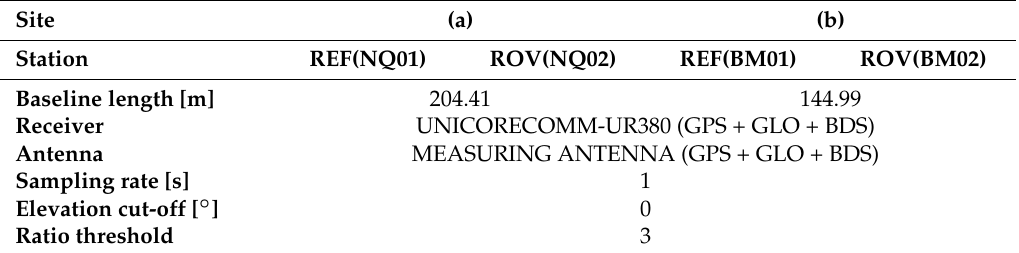
Table 1. Monitoring datasets used for the investigation, and the types of receivers and antennas used. (REF and ROV denote the reference station and rover station, respectively).